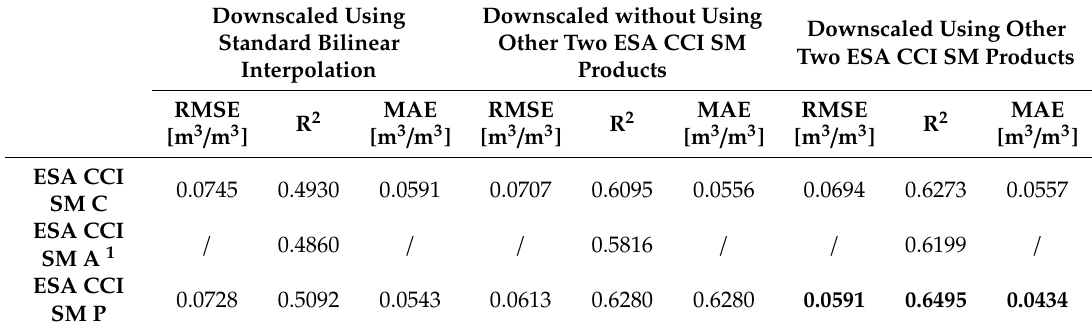
Table 1. The validation metrics of downscaled ESA CCI SM 1-km products obtained by using in situ